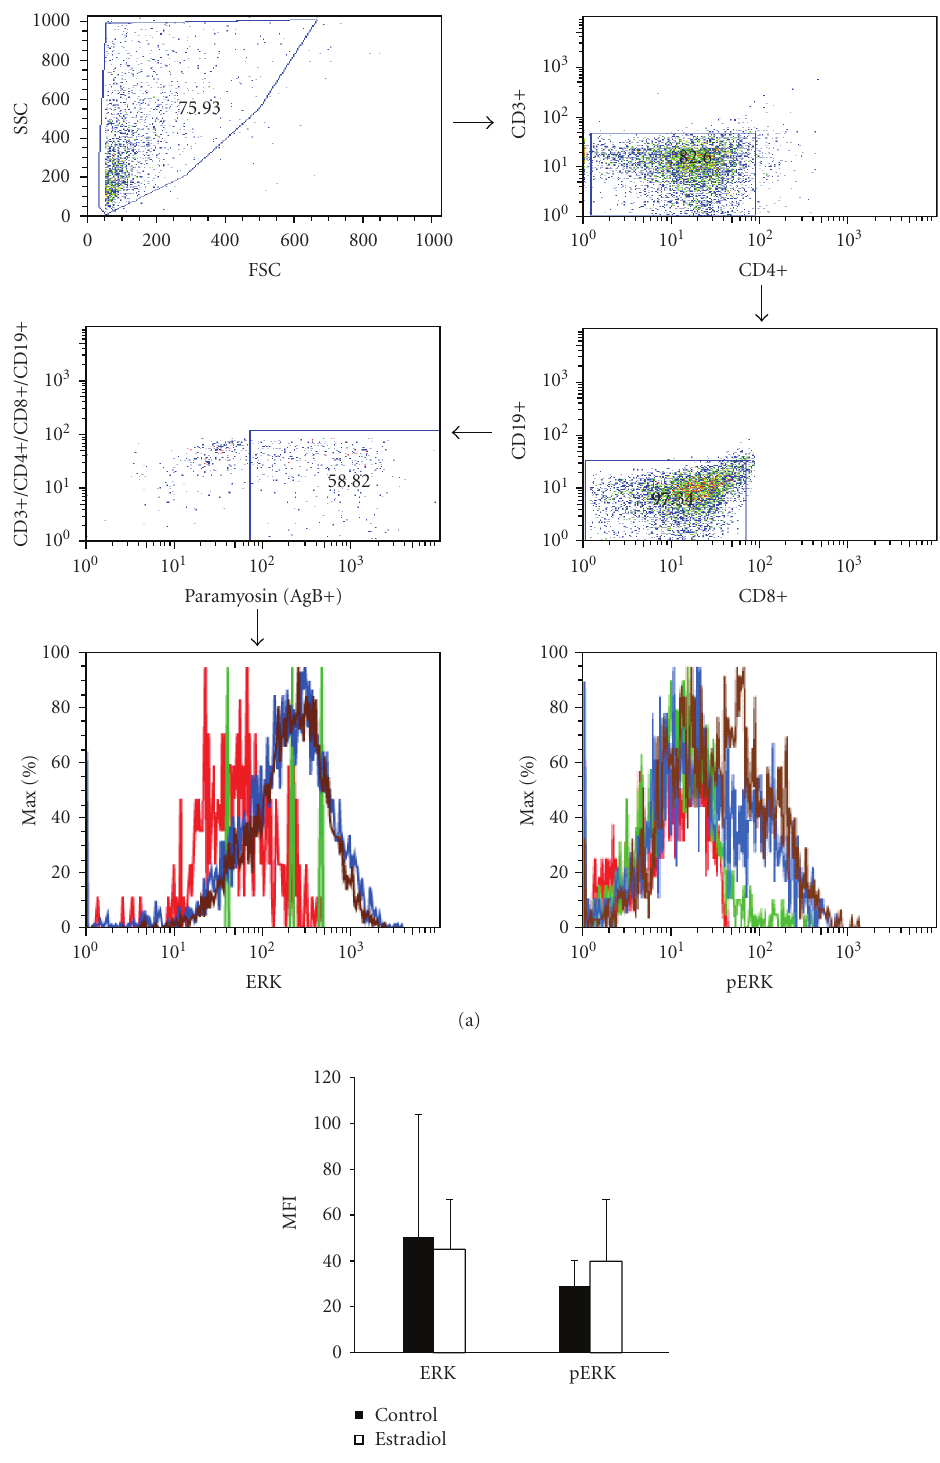
Figure 4: Specific detection of ERK-like in Taenia crassiceps . FACS assays showed that ERK-like detected in T. crassiceps was not a contamination product from host immune cells CD3+, CD4+, CD8+, and CD19+. As expected, ERK-like was specifically detected in paramyosin positive cells, a cytoskeleton protein only present in cestodes and some insects (a). By using the Mean of Fluorescence Intensity (MFI), no di ff erences in total ERK-like and pERK were observed between control and 17 β -estradiol cysticerci (b). Control = Parasites treated with the vehicle where hormone and inhibitors were dissolved. Red = unstained cells; green = control parasites; blue = E 2 -treated parasites; brown = ERK inhibitor-treated parasites; SSC = Side Scatter; FSC = Forward Scatter; pERK = ERK phosphorylated form; MFI = Fluorescence